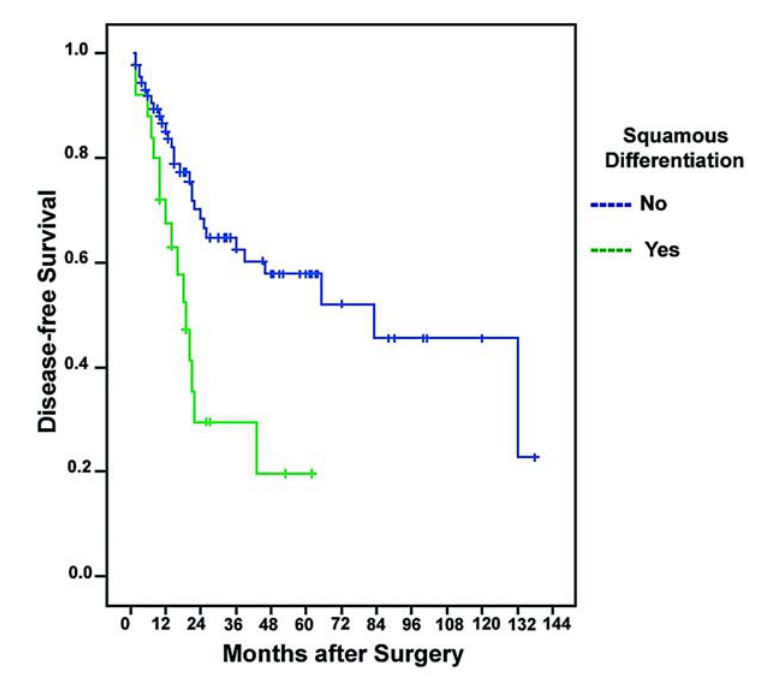
Figure 2 – Disease-free survival among patients with and without squamous differentiation (log-rank test; p = 0.001).